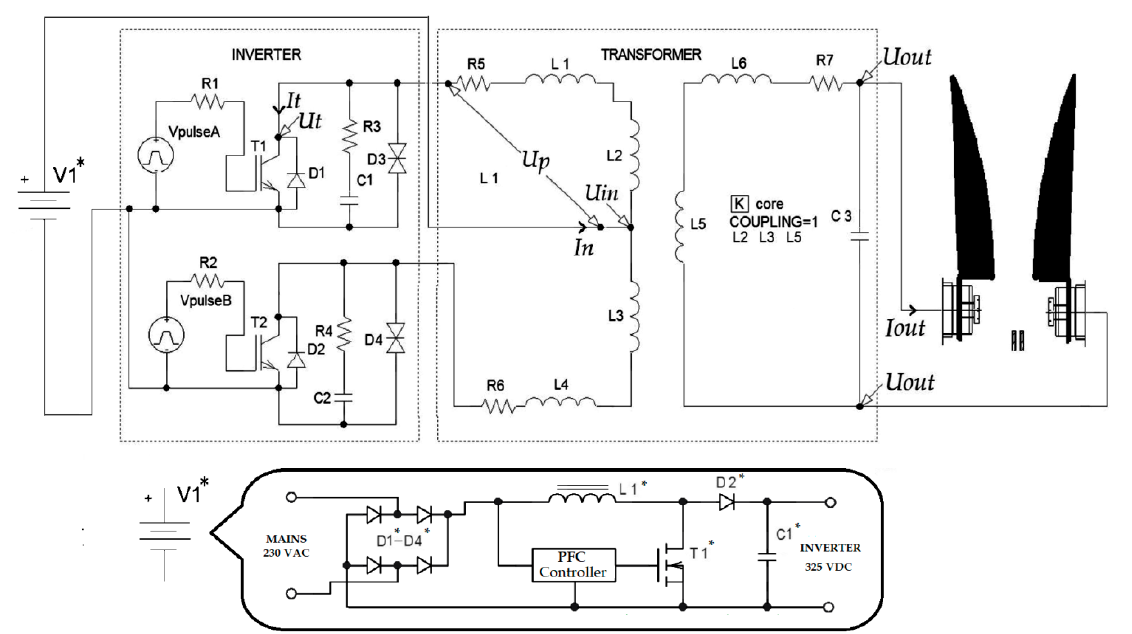
Figure 1. Simplified schematic diagram of the described processes of energy conversion in switched- mode push–pull power supply for micro gliding arc discharge reactors ( μ GAD).